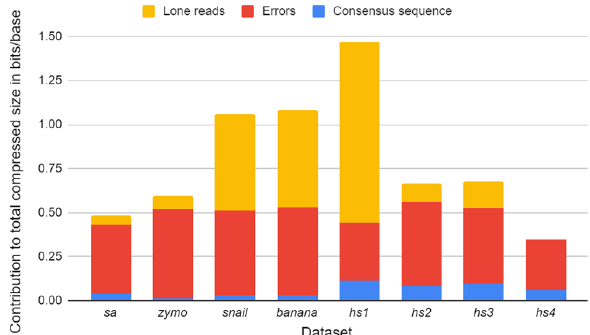
Figure 3. Contribution of consensus sequence, errors and lone reads to the compressed size across datasets.